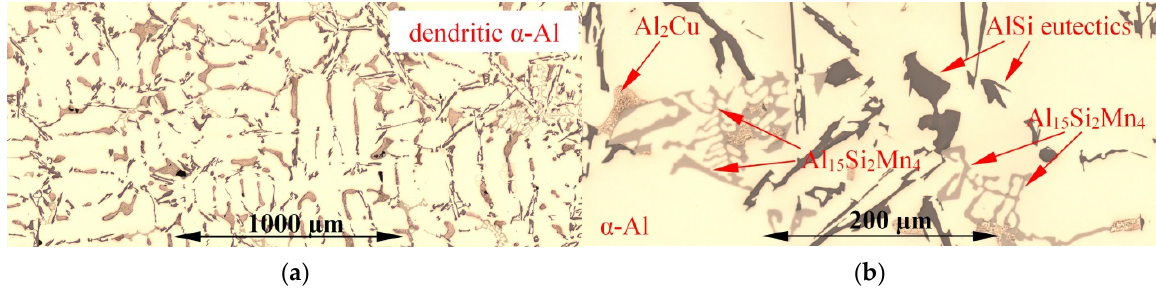
Figure 7. The microstructures of the AlCu4Si6Mn0.65 specimen solidified without electromagnetic stirring. LOM: ( a ) mag- nification 100 and ( b ) magnification 500×.